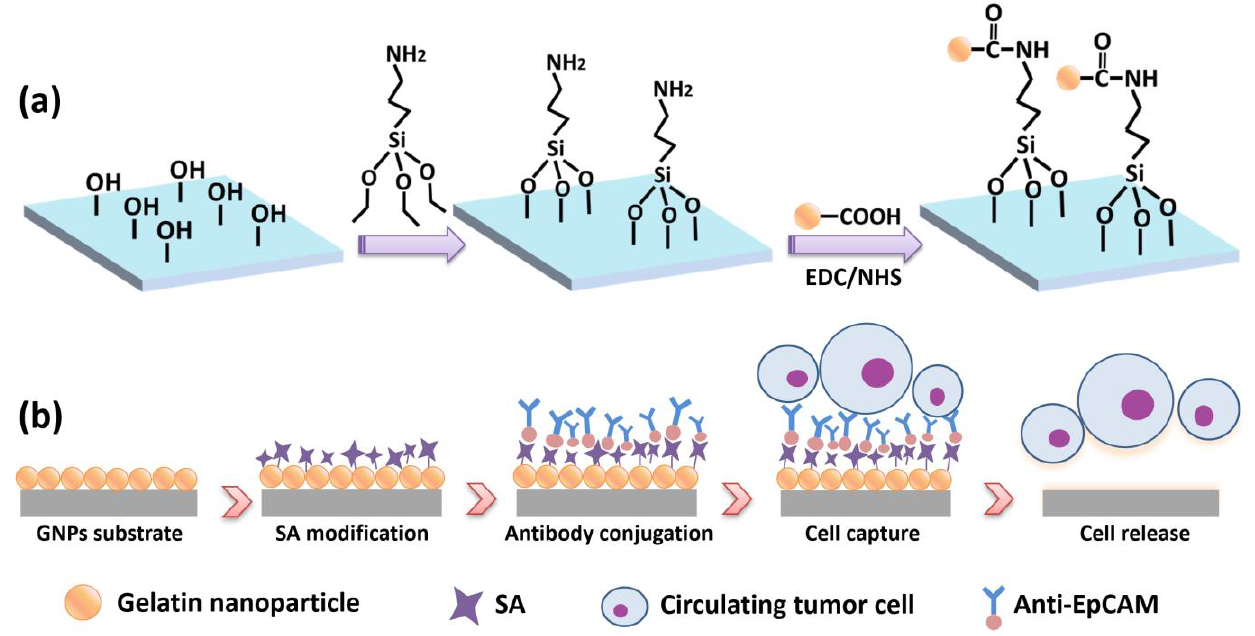
Figure 1. Schematic diagram of GNP-coated chip. ( a ) GNP substrate fabrication process; ( b ) antibody modification of the substrate for CTC capture and release.